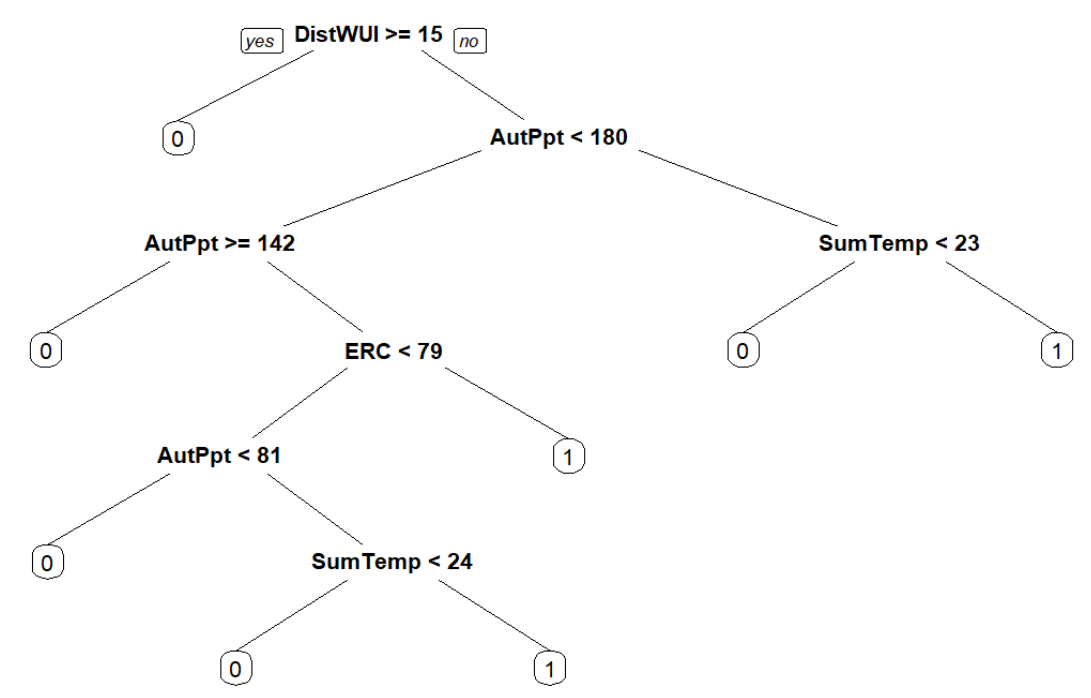
Figure 6. Classification tree explaining the factors differentiating destructive (1) and non-destructive (0) wildfires ≥ 100 ha from 2000 – 2018 in the North Sierra Foothills of California.